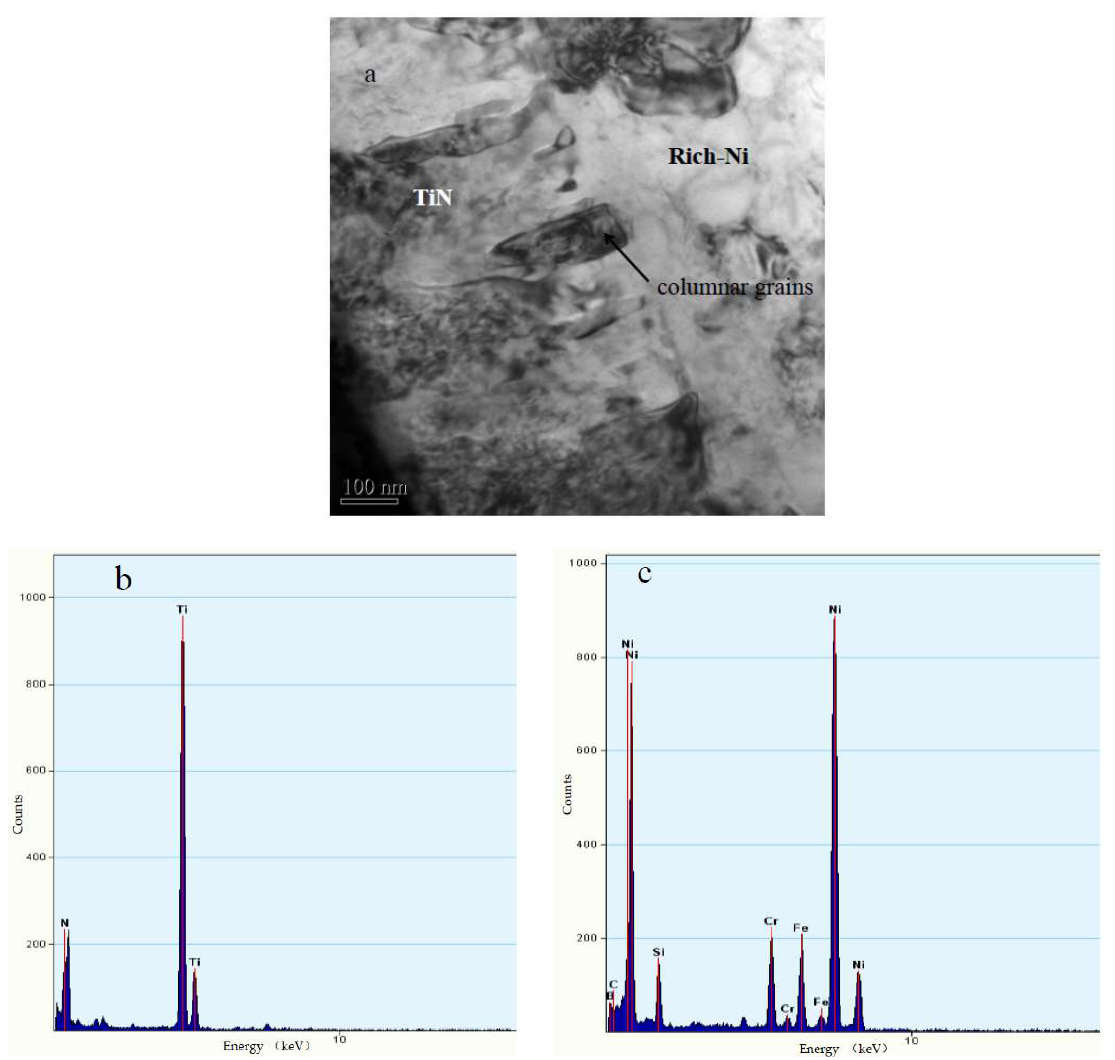
Figure 6. ( a ) TEM image of interfaces between TiN and γ-Ni layer; ( b,c ) EDS spectra.